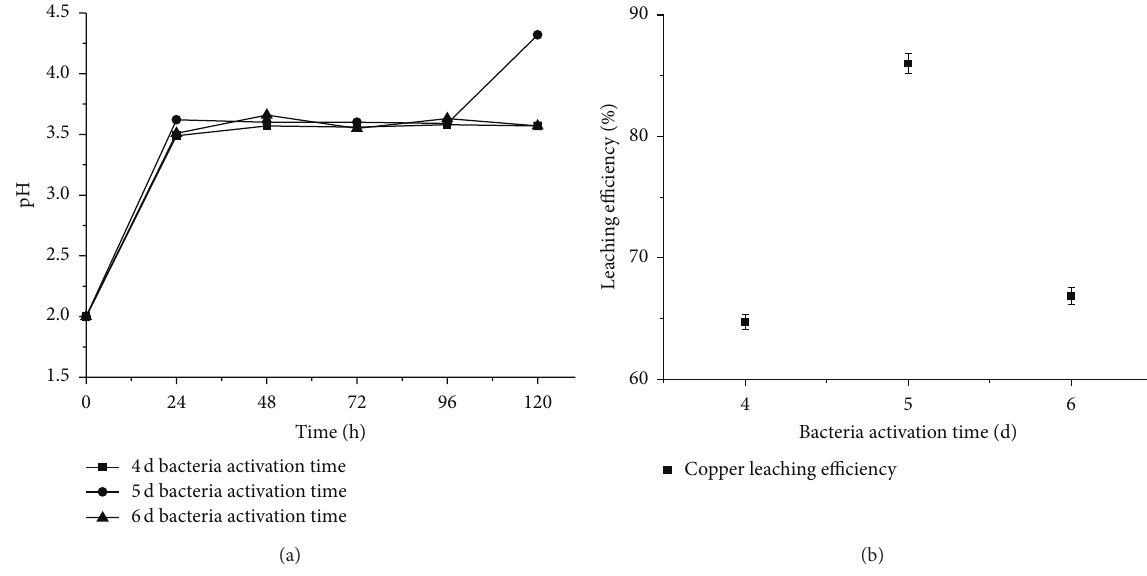
Figure 6: Different activation time and medium pH changed with time (a) and 5 days leaching and copper leaching efficiency